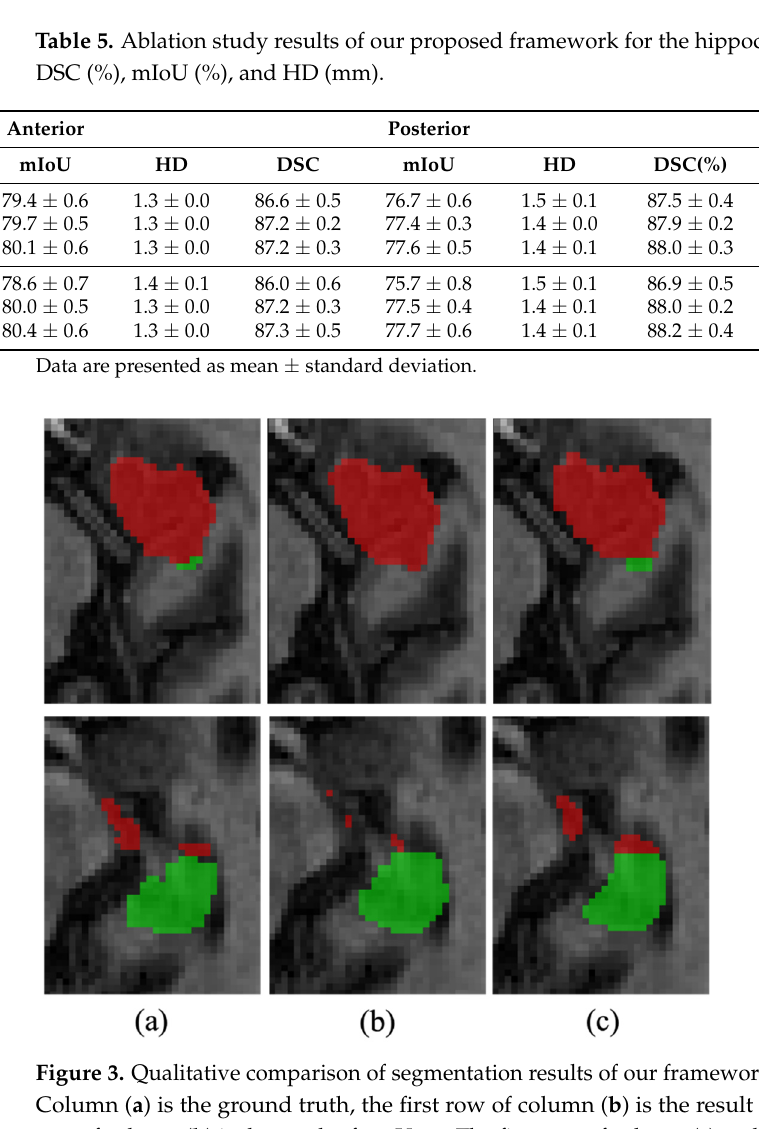
Figure 3. Qualitative comparison of segmentation results of our framework on hippocampus dataset. Column ( a ) is the ground truth, the first row of column ( b ) is the result of Segnet, and the second row of column ( b ) is the result of nn-Unet. The first row of column ( c ) and the second row of column ( c ) are the results of our method implemented on Segnet and nnUNet. The red and green regions represent the anterior and posterior of the hippocampus, respectively.